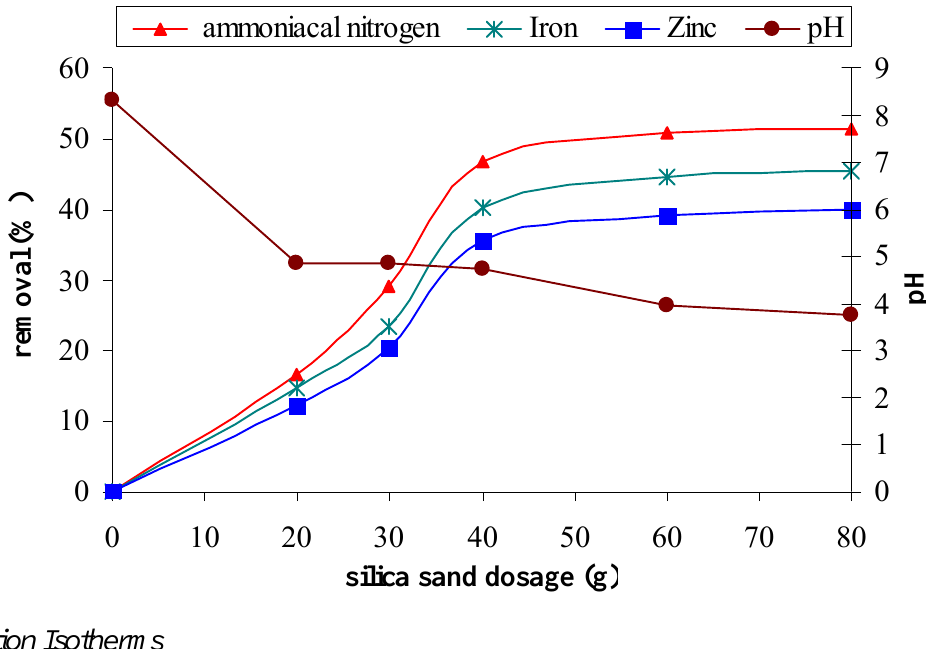
Figure 3. Influence of silica sand dosage on ammoniacal nitrogen, iron and zinc removal efficiency (shaking speed = 350 rpm; shaking time = 90 min; settling time = 60 min).